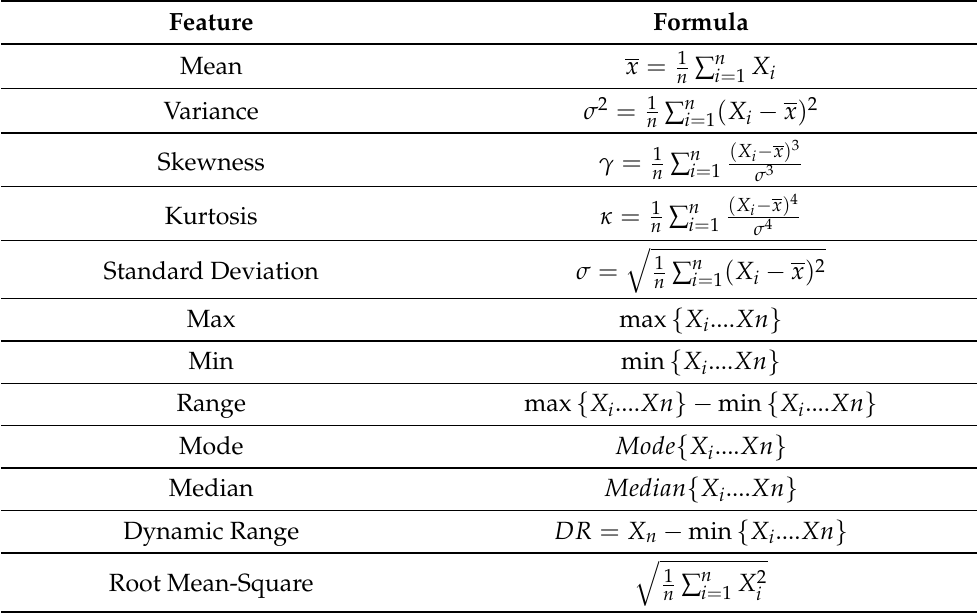
Table 7. Time-domain features extracted from inertial sensors based on statistics for road surface anomaly detection and classification [5,18,37,56]. The n term refers to the length of the signal segment and X i is one single sample of the